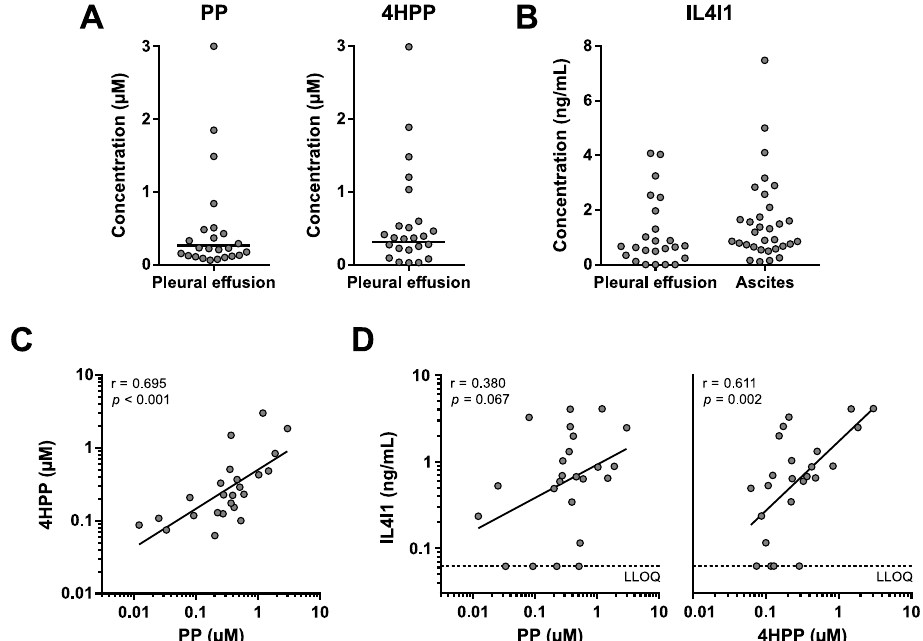
Figure 7. PP, 4HPP and IL4I1 levels in pleural effusion samples of patients with stage IV non-small cell lung cancer. ( A ) PP and 4HPP levels in pleural effusion samples ( n = 24). Horizontal lines indicate geometric means. ( B ) IL4I1 levels in pleural effusion of non-small cell lung cancer patients ( n = 24) and ascites of high-grade serous ovarian cancer patients ( n = 32). IL4I1 levels in four pleural effusion displayed. ( C , D ) Correlation between PP, 4HPP and IL4I1 levels in pleural effusion samples. Dashed lines indicate the LLOQ. Samples with an IL4I1 level below the LLOQ are shown at the LLOQ